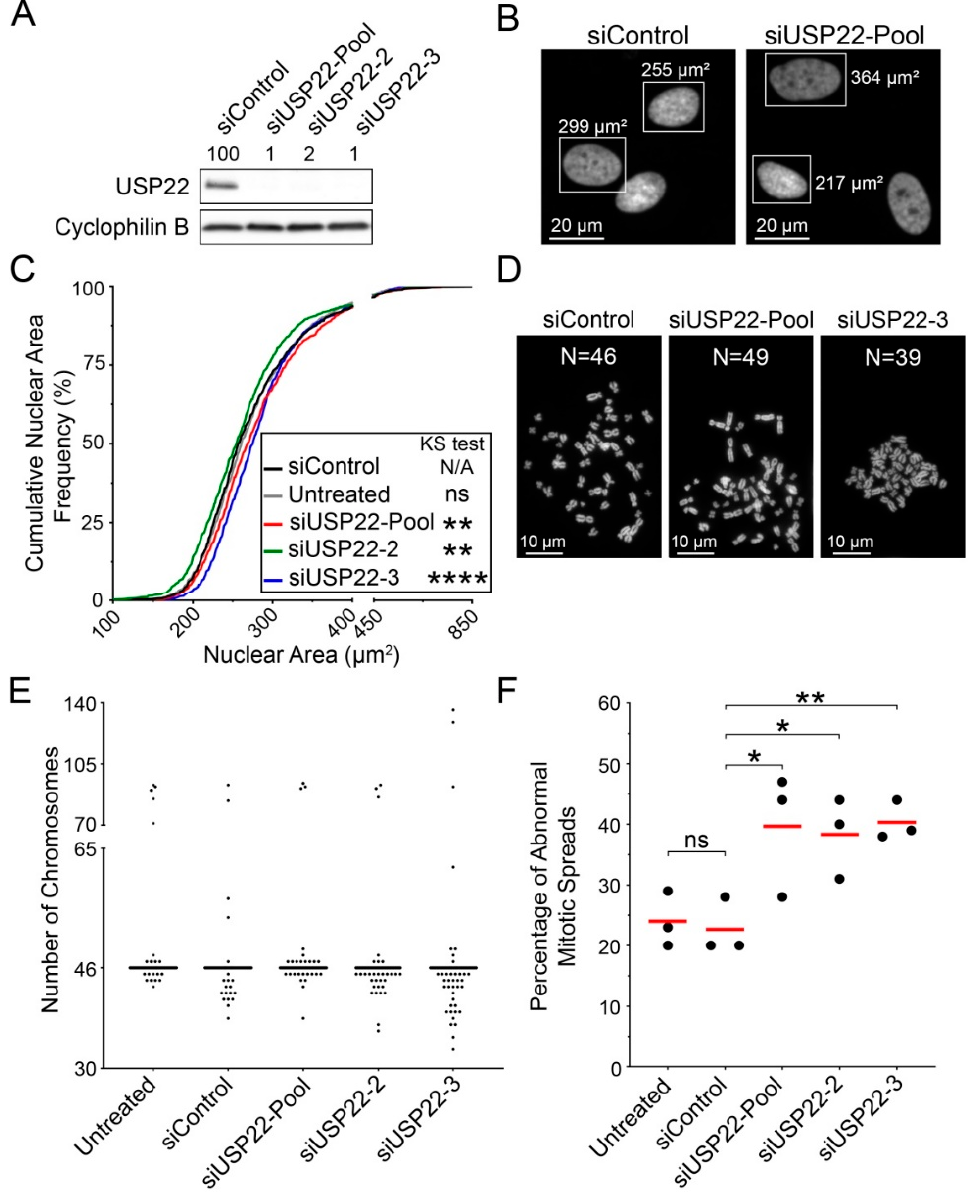
Figure 5. USP22 silencing induces CIN phenotypes in hTERT cells. ( A ) Western blot showing decreases in USP22 abundance following silencing; cyclophilin B is the loading control. Semi-quantitative analyses were performed and the normalized USP22 levels are presented relative